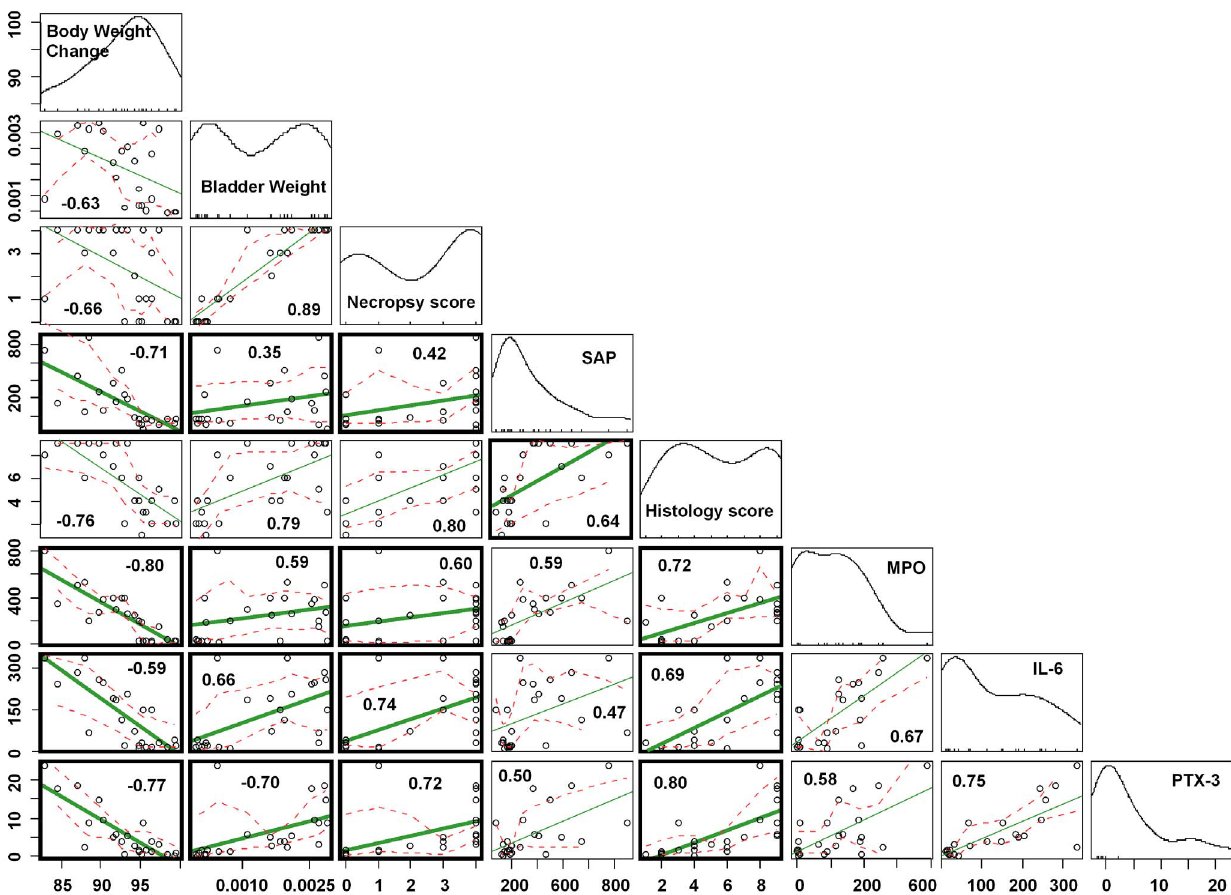
Figure 6. Multivariate analysis of various observations in LL-37 induced cystitis model and the inhibitory effects of GM-0111. Each intersecting graph shows the correlation between the two respective observational parameters. Graphs in the diagonal array represent the distribution of data from each parameter pooled from normal and LL-37/GM-0111 treated animals. Green lines indicate the correlation in each set of parameters and red dotted lines indicate the values following similar trends. Bold rectangular areas represent the correlation between physiological measurements and the concentrations of molecular markers. The values inside boxes are Spearman correlation coefficients ( r ).